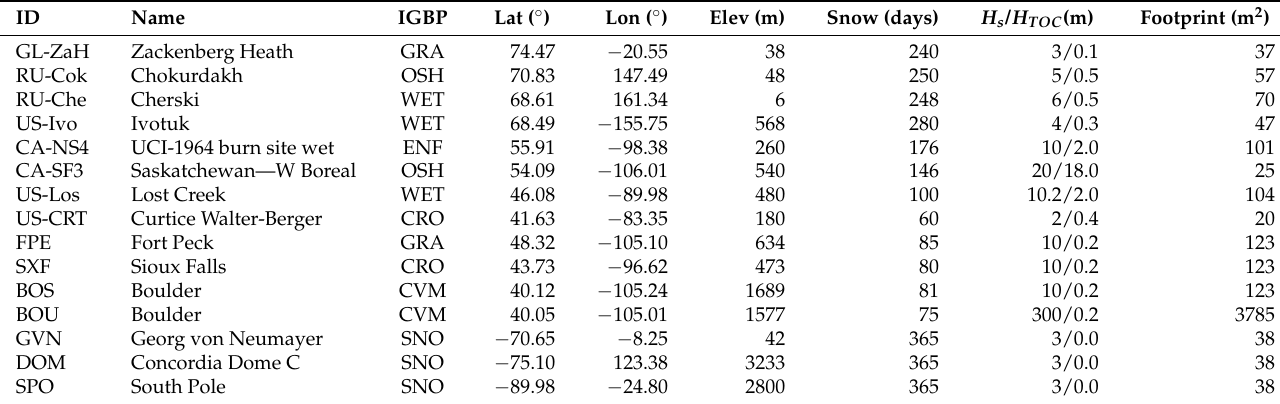
Table 2. Description of FLUXNET and BSRN stations evaluated with the variogram-based proce- dure. H s and H TOC stand for sensor and top-of-canopy heights, respectively. International Geo- sphere–Biosphere Programme (IGBP) land cover classification: GRA = grasslands, OSH = open shrublands, WET = permanent wetlands, ENF = evergreen needleaaf forests, CRO = croplands, CVM = cropland/natural vegetation mosaics, SNO = snow and ice.